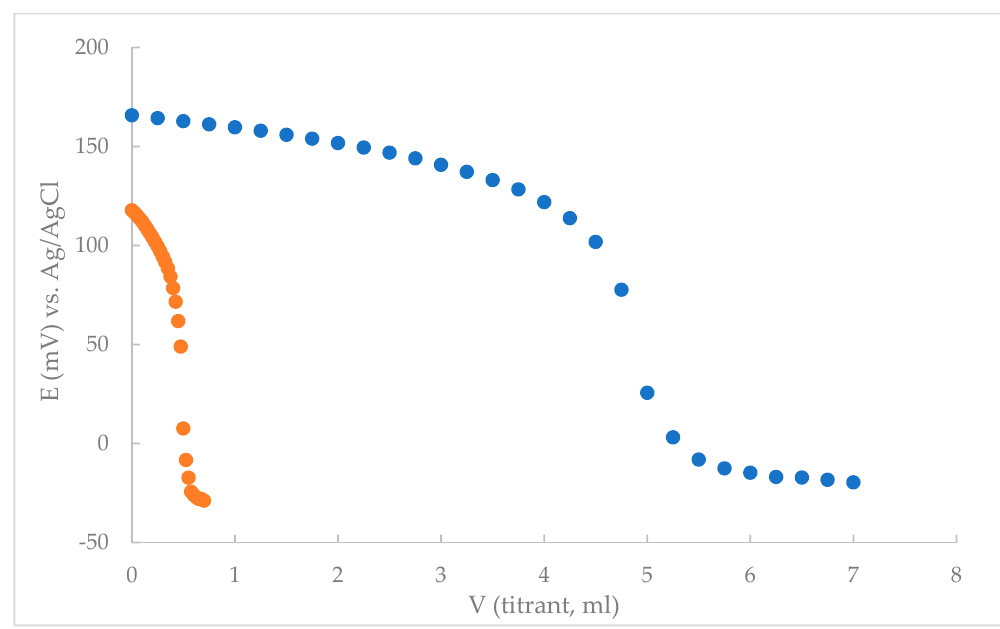
Figure 6. A typical potentiometric titration curve for 50 mL aliquot of Parkopan tablets. Table 3. Analysis of THP in pure solution, pharmaceutical formulation, and spiked urine sample using different methods.